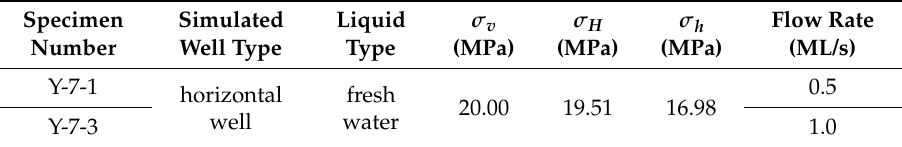
Table 2. Experimental scheme and parameters.